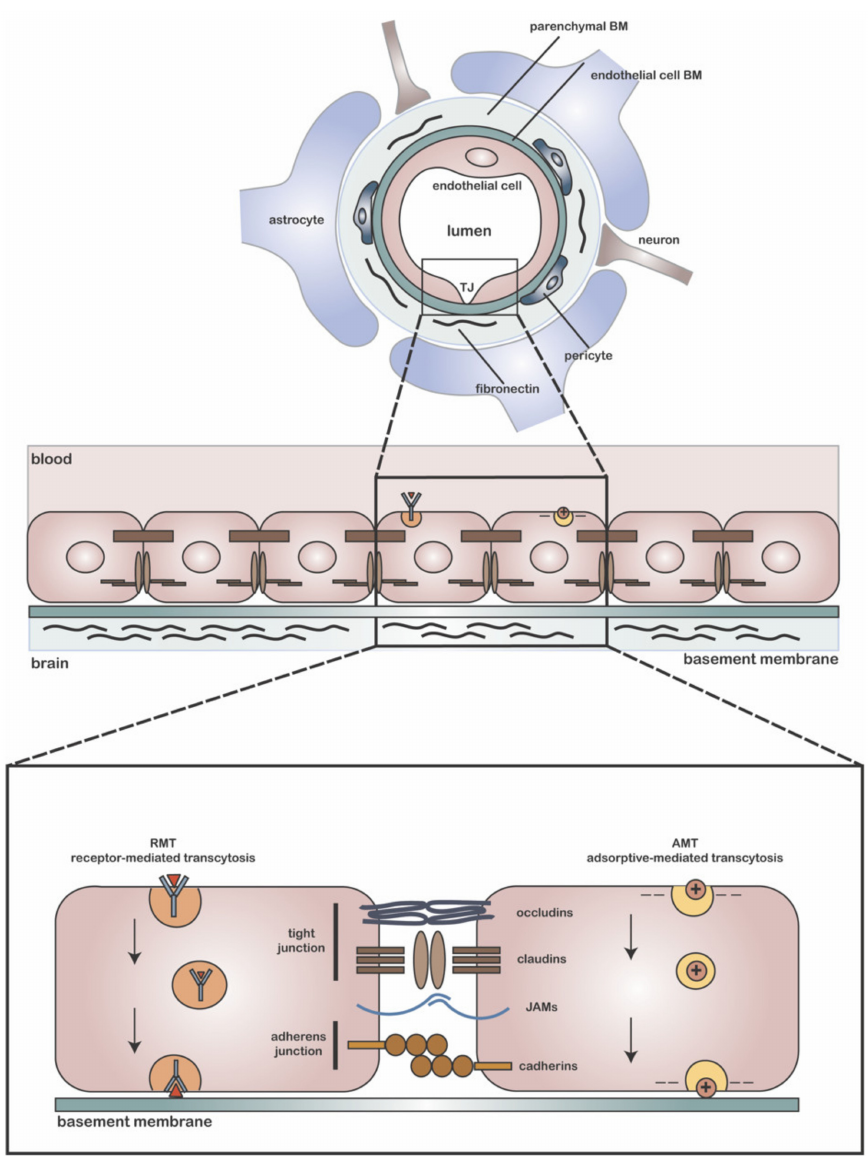
Figure 1. Schematic representation of the blood–brain barrier and active transport mechanisms. The blood–brain barrier (BBB) is formed by a monolayer of specialized endothelial cells, which form together with pericytes, astrocytes, and the basement membrane (BM) to create the neurovascular unit. The BM is a thin sheet of supporting extracellular matrix, including fibronectin, and is composed of endothelial BM and the astrocyte-derived parenchymal BM. Endothelial cells are tightly connected via tight and adherens junctions, which prevent the paracellular passage of molecules. Active transport mechanisms across the BBB include receptor-mediated transcytosis (RMT) or adsorptive- mediated transcytosis (AMT). RMT involves ligand–receptor binding, followed by endocytosis of the receptor complex, intracellular trafficking, and exocytosis at the basal membrane [114]. Conversely, cationic molecules can interact with the negatively charged membrane, thereby inducing transcellular transport of the positively charged molecule. See the text for more details. JAM—junction adhesion molecule; TJ—tight